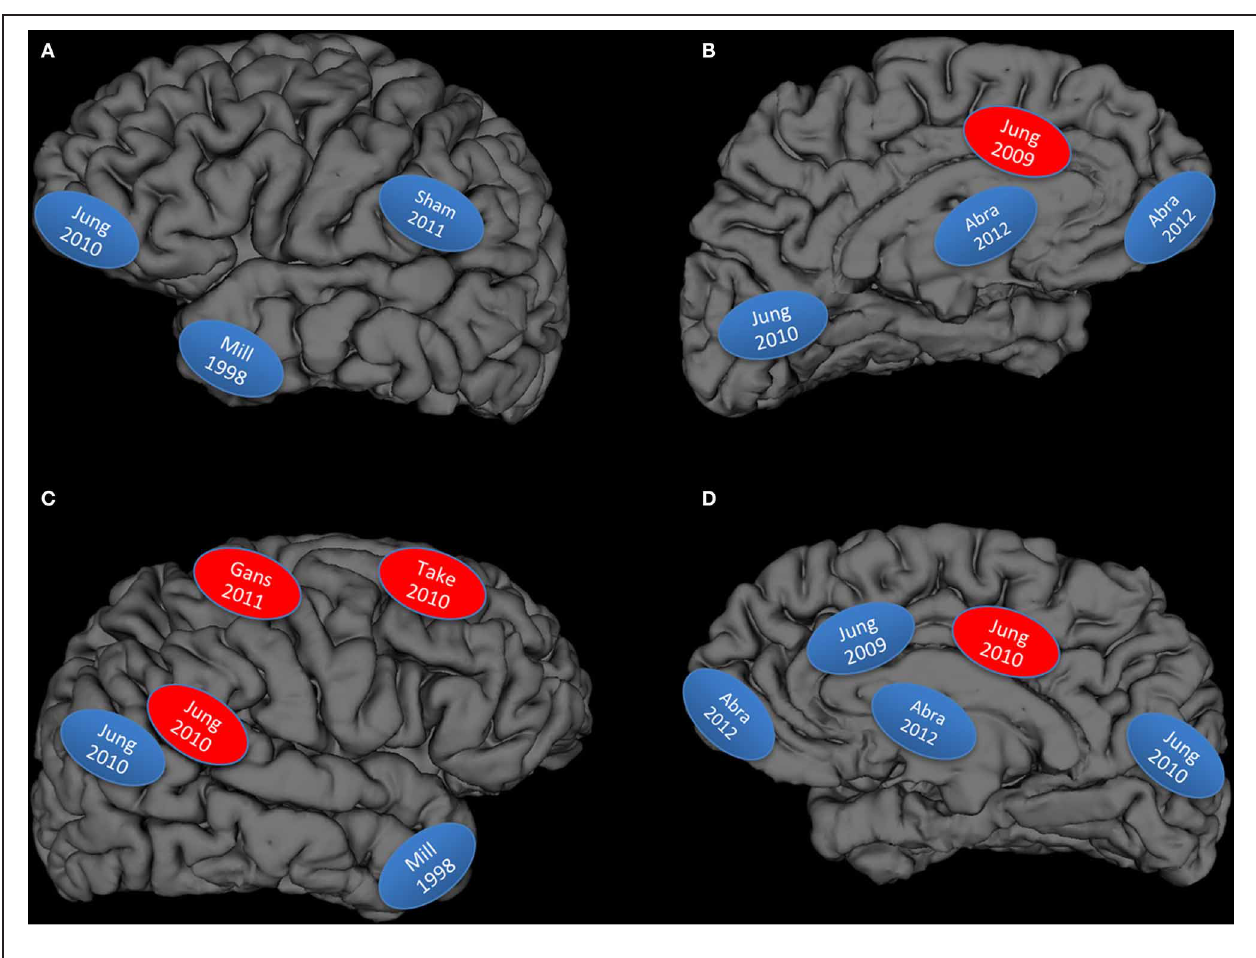
FIGURE 1 | Graphical display of studies reviewed: Blue, lower brain integrity measures associated with higher creativity measures; Red, higher brain integrity measures associated with higher creativity measures; (A) left lateral hemisphere; (B) left medial hemisphere;